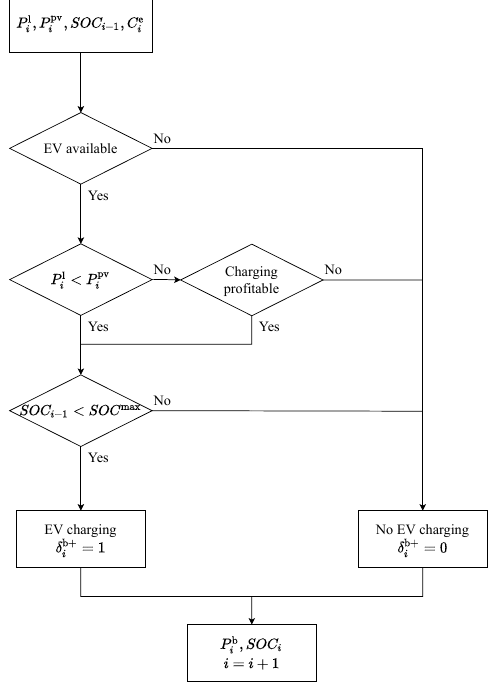
Figure 4. Optimal charging strategy flowchart.